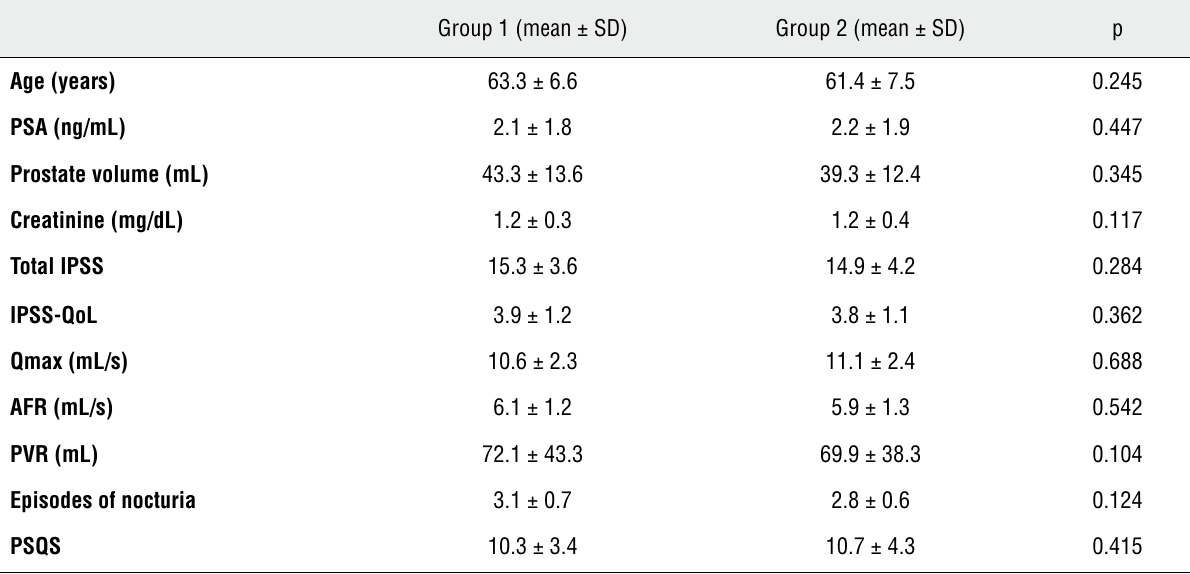
Table 1 - Baseline characteristics of the patients for both